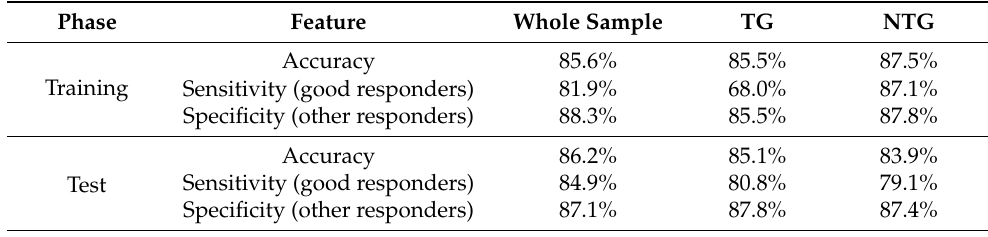
Table 2. Accuracy, Sensitivity, Specificity, and Area Under the ROC Curve of the ANN in identifying the correct outcome of patients.